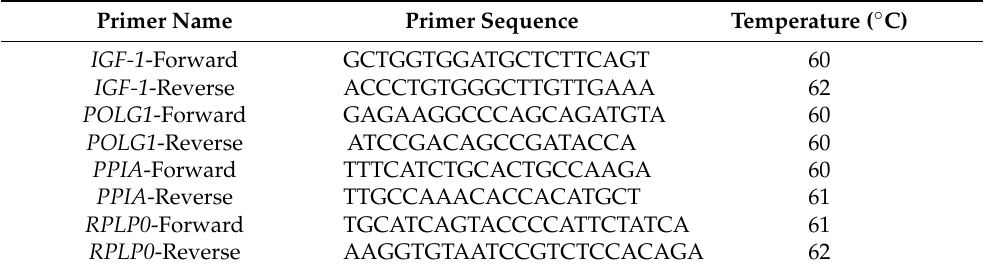
Table 1. Primers of qPCR.